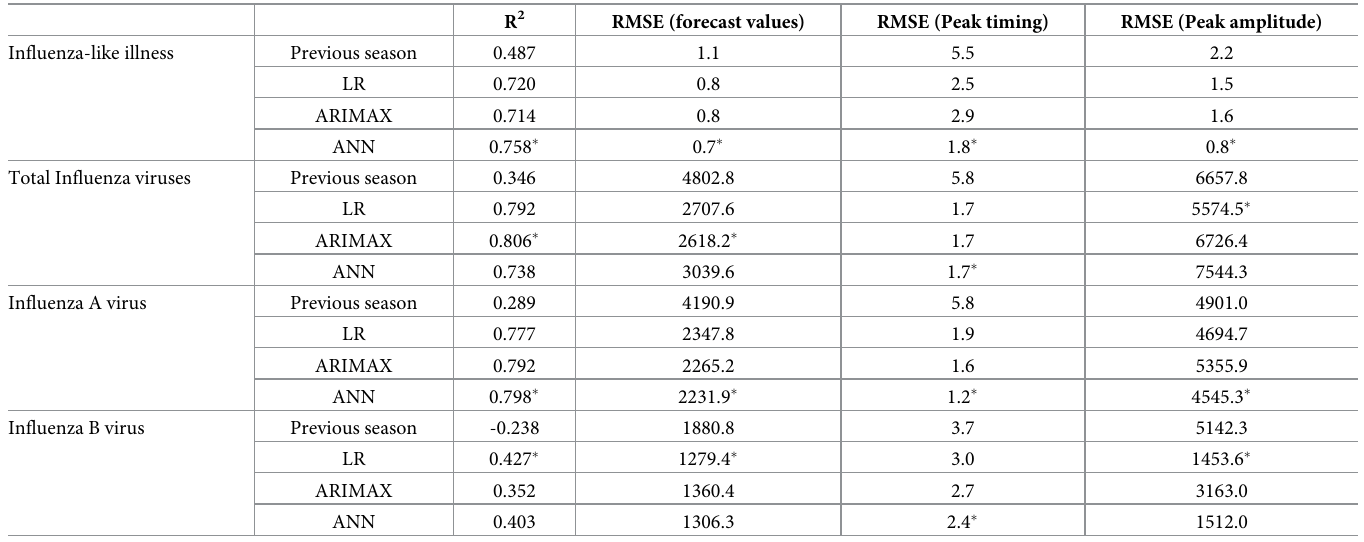
Table 3. Performance of prediction models for seasonal influenza outbreaks after 26 weeks in the United States from 2015 to 2019.